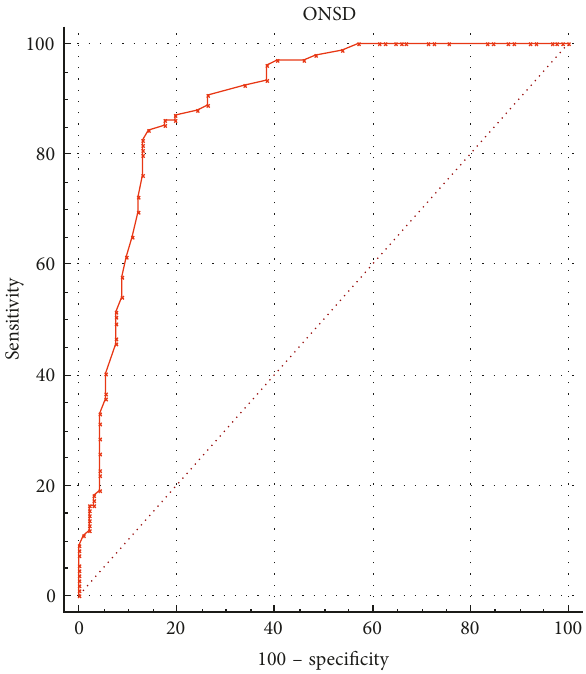
Figure 4: Receiver operating characteristic curve analysis showing the predictive value of the optic nerve sheath diameter (ONSD) measurements for elevated intracranial pressure (ICP; Diagonal segments are produced by